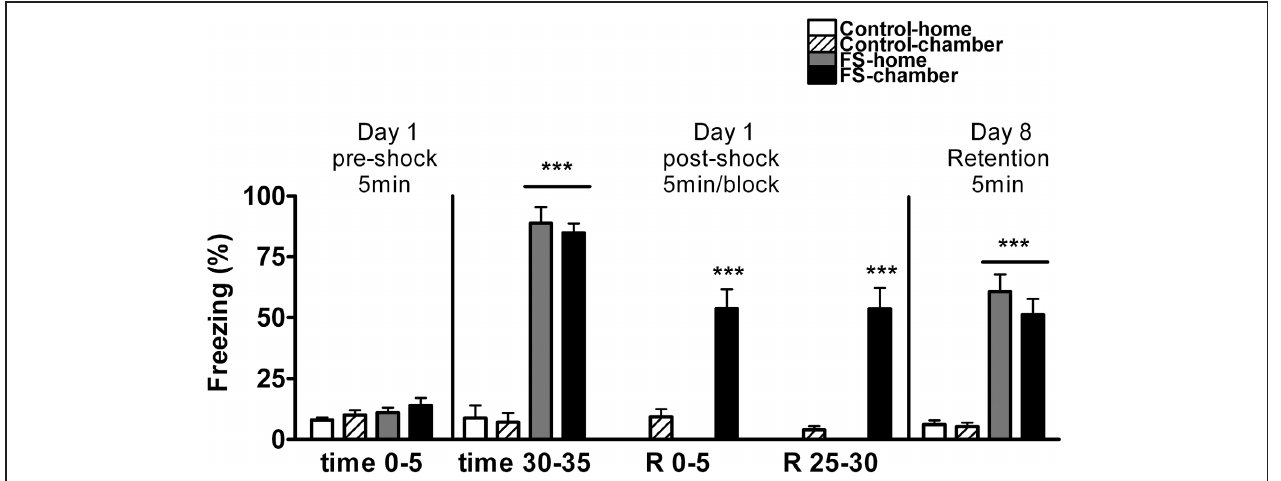
FIGURE 2 | Percentage of time spent freezing for Experiment 1 on day 1 (pre-shock period and several post-shock periods), and day 8 (retention). Means and SEM are represented. The groups were as follows: control-home, not shocked during the 35min exposure to the shock chamber and returned to the home-cage after that; control-chamber, not shocked during the 35min